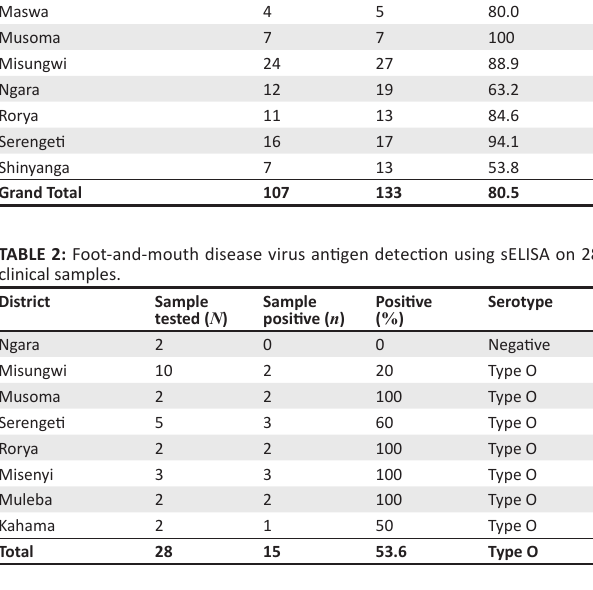
Legend Serotype O.csv